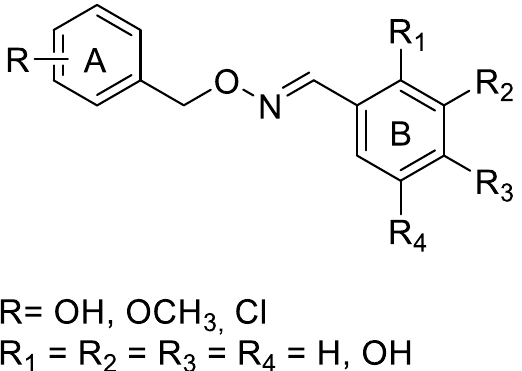
Figure 2. Chemical structure of the compounds in our in-house chemical library.